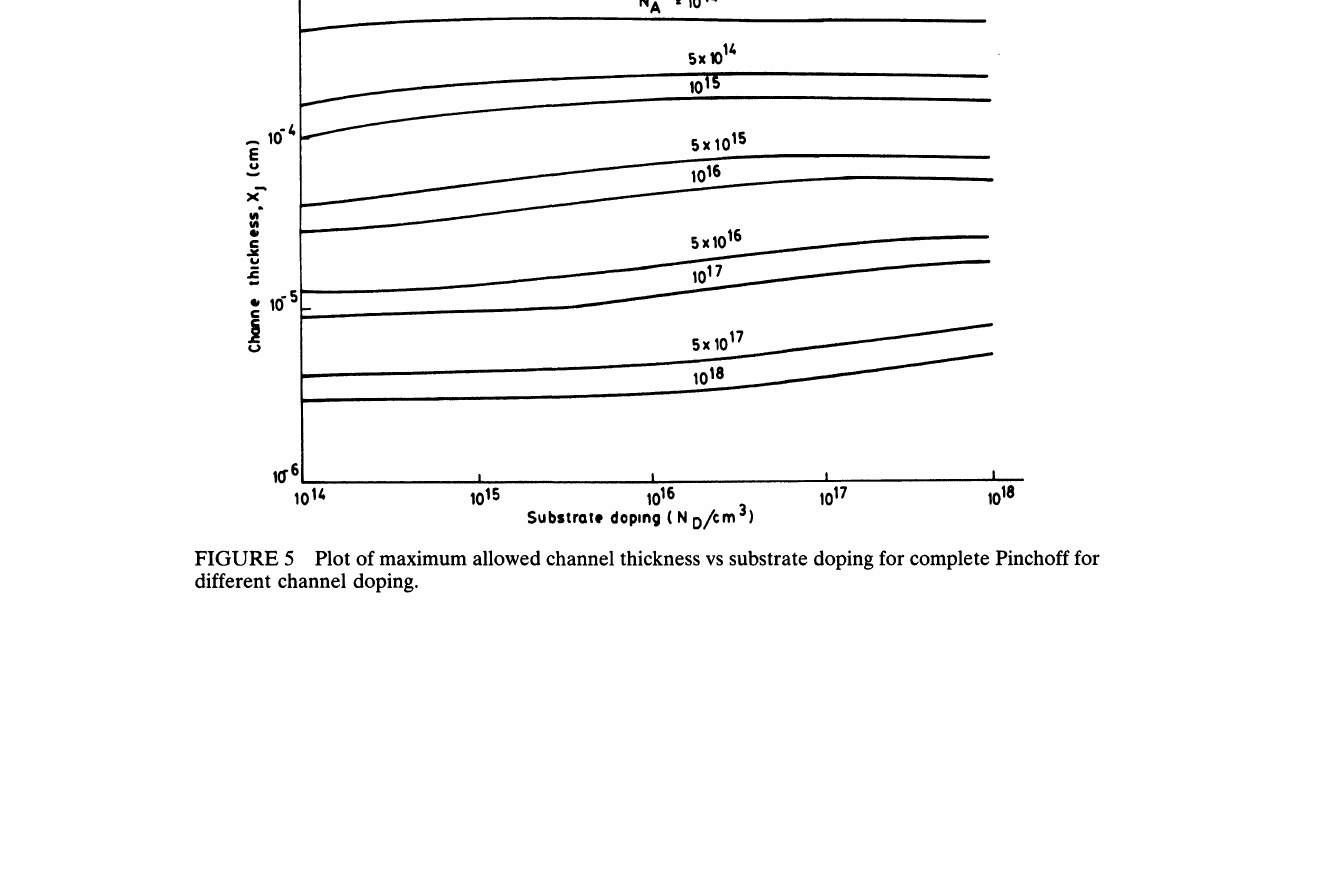
FIGURE 4 Plot of maximum allowed channel thickness vs. channel doping for complete Pinchoff for different substrate dopings.